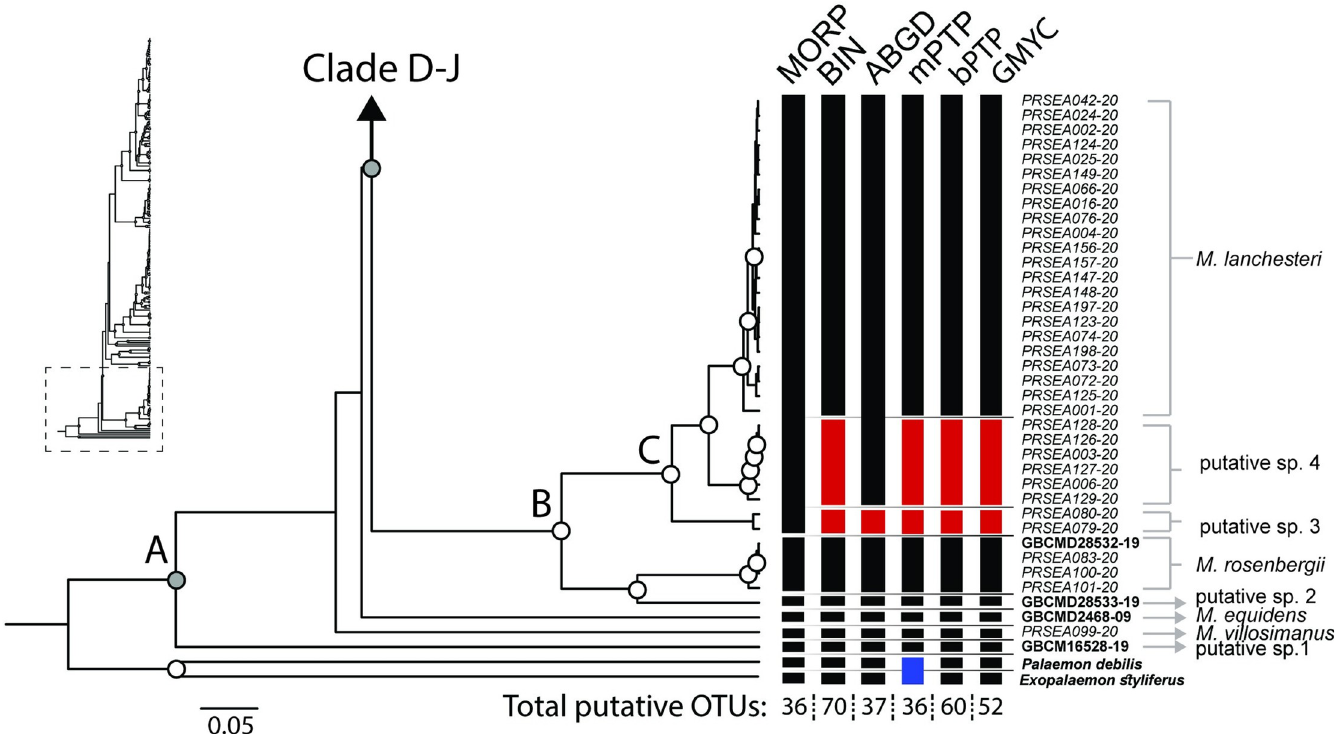
Fig 3. Ultrametric tree of Indochinese Macrobrachium indicating clade support level and species delimitation clustering results (part 1). Abbreviations used on tree are as follows: Morpho, morphological identification; BIN, BIN method in BOLD; ABGD, automated barcode gap; bPTP, Bayesian Poisson tree processes; mPTP, multi-rate Poisson tree processes; GMYC, generalized mixed Yule coalescent model. Box colors indicate split (red) and lumped (blue) species recognized by each species delimitation method. Grey boxes indicate missing sequences. Morphological data from dataset in each delimitation method; sample ID with bold style indicates samples obtained from BOLD and NCBI. The horizontal line and species labels show the consensus result of species clustering.